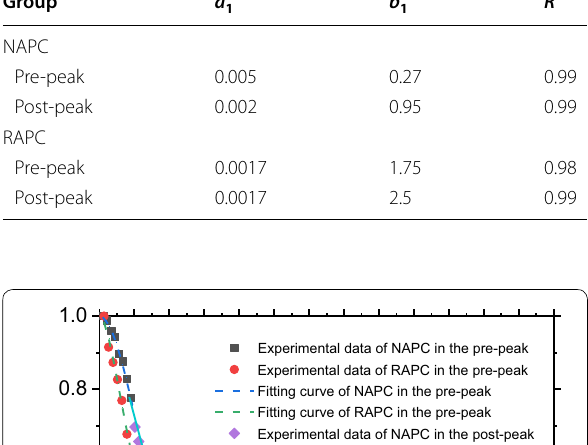
Table 7 Fitting values of parameter a